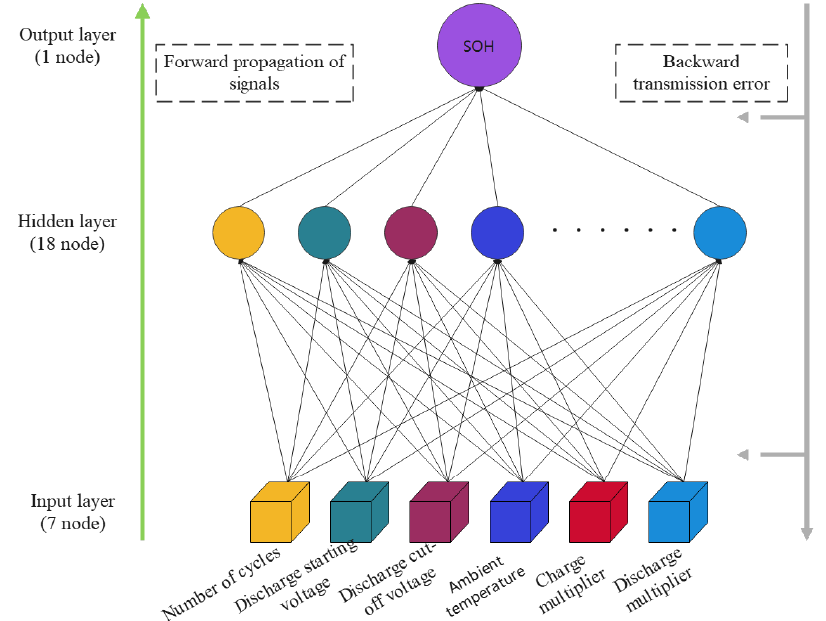
Figure 6. BP neural network structure.